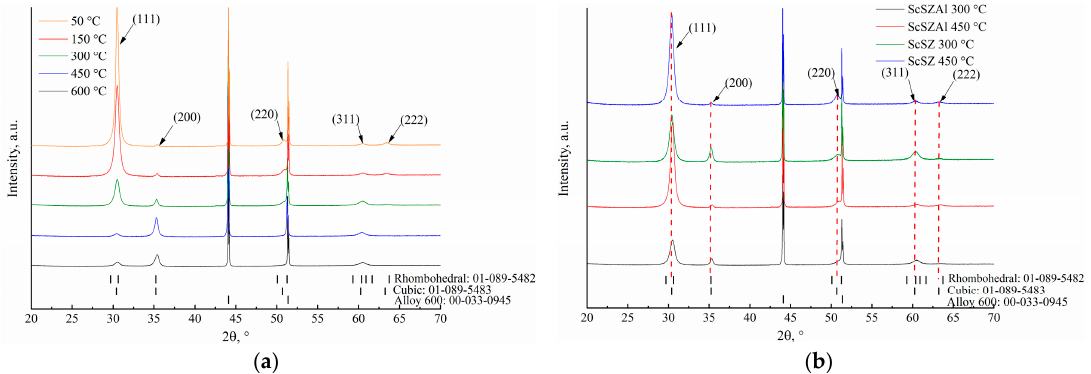
Figure 2. XRD patterns (measured at room temperature) of ( a ) ScSZAl thin films and ( b ) ScSZ and ScSZAl thin films deposited on Alloy 600 substrates using a 0.4 nm/s deposition rate.